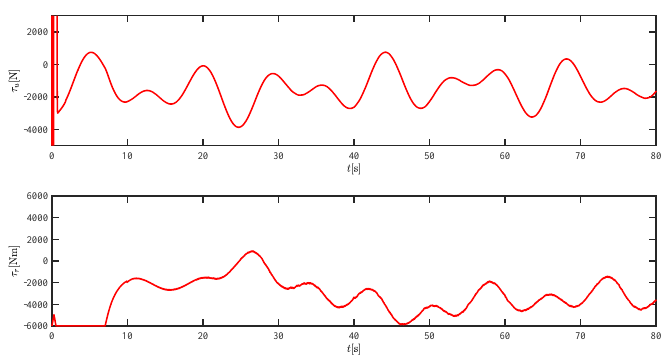
Figure 20. The lumped disturbances and their estimations at moderate speed.